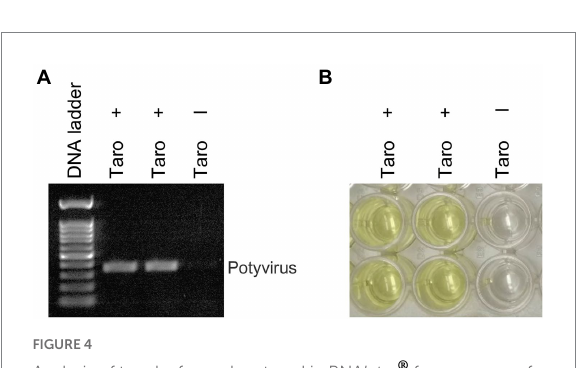
FIGURE 3 Analysis of overlapping RT-PCR DNA fragments (F1 to F8) covering full-length PRSV genomes using published PRSV primer sequences for Hawaii isolate (HA) or using primers designed based on HTS analysis for PRSV Bangladesh isolates BD1 and BD2 and total RNA from symptomatic papaya leaf samples stored in RNA later ® for one-month. Size ranges of PCR fragments are shown at right.